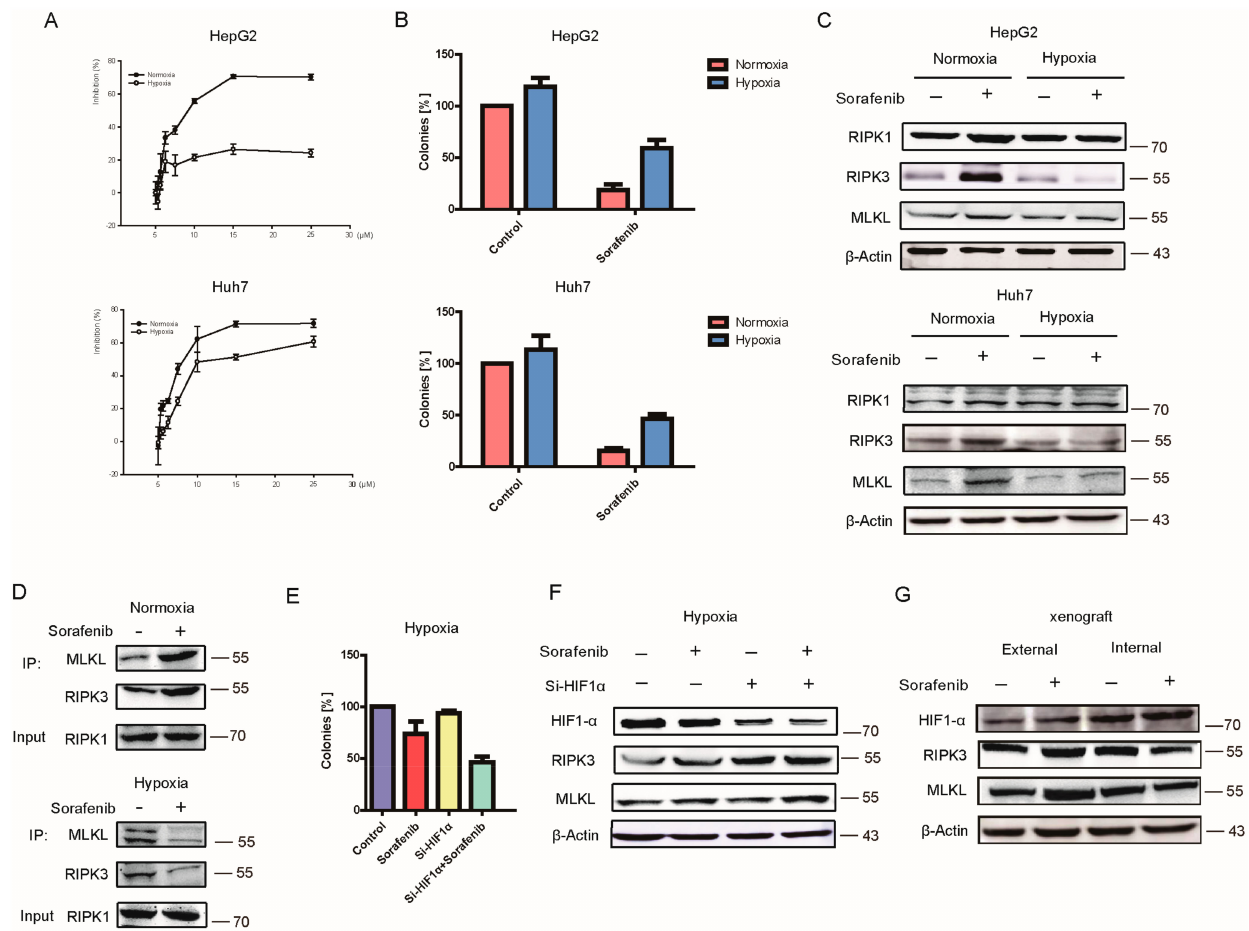
Figure 2. Hypoxia Induced Hepatocellular Carcinoma Resistant to Sorafenib. (A) Inhibition of Sorafenib under normoxia and hypoxia assessed by MTT assay. ( B ) Inhibition of Sorafenib under normoxia and hypoxia assessed by Clone formation experiment. ( C ) The expression of necroptosis proteins in normoxia and hypoxia detected by Western Blot. ( D ) The binding capacity of the necroptosis complex under normoxia and hypoxia. ( E , F ) HIF1 α effect on Sorafenib observed by Soft Agar Cloning experiment. ( F ) HIF1 α effect on Sorafenib in necroptosis pathway detected WB. ( G ) Detected HIF1 α and necroptosis protein in PDX-xenograft tumor tissues by